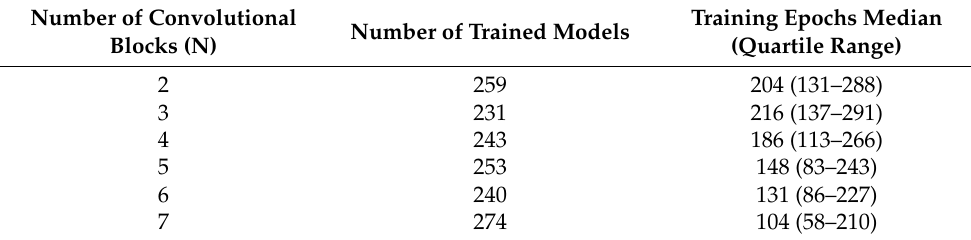
Table 3. Trained CNN models by HP random